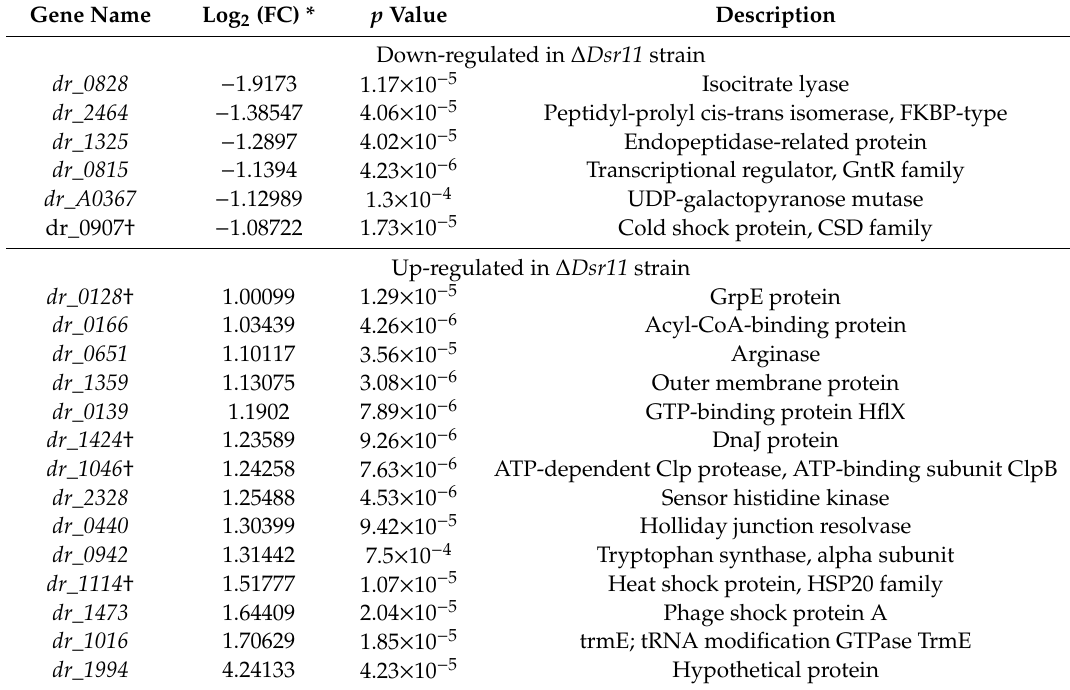
Table 1. Selection of the most representative genes di ff erentially expressed in D. radiodurans dsr11 deletion mutant with Log 2 (FC) > 1 or Log 2 (FC) <